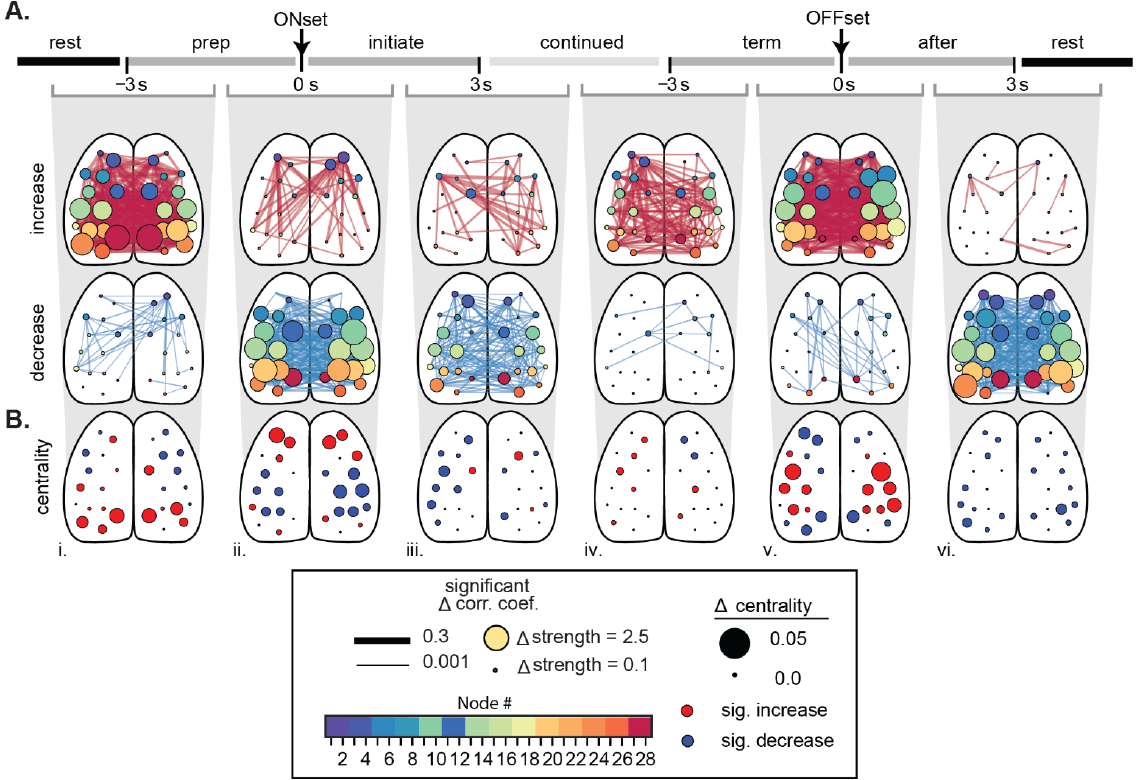
Figure 3. Cerebral cortical functional connectivity and centrality undergo large shifts from rest to locomotion and return to rest. ( A ) Significant changes in correlations between nodes during treadmill locomotion across sequential behavior periods ( α < 0.05, with false discovery rate correction). The nodes and changes in functional connectivity are superimposed on the cortical surface. Significant increases shown in red (top) and decreases in blue (bottom). Directly above, the grey bracket indicates the adjacent behavior periods being compared ( i – vi ). The size of each node reflects the magnitude of significant increases or decreases, respectively. ( B ) Significant change in eigenvector centrality across the sequential behavior periods as in ( A ). Size of circles denote the magnitude of the change, while circle color is the direction of significant change (red = increase, blue = decrease, black = not significant; α < 0.05, with false discovery rate). Modified from [61] with permission.